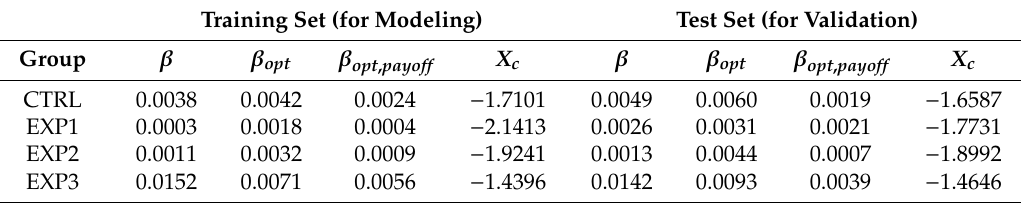
Table 6. Summary of β and X c values for the selected LR model, for control and experimental groups. Training Set (for Modeling) Test Set (for Validation)